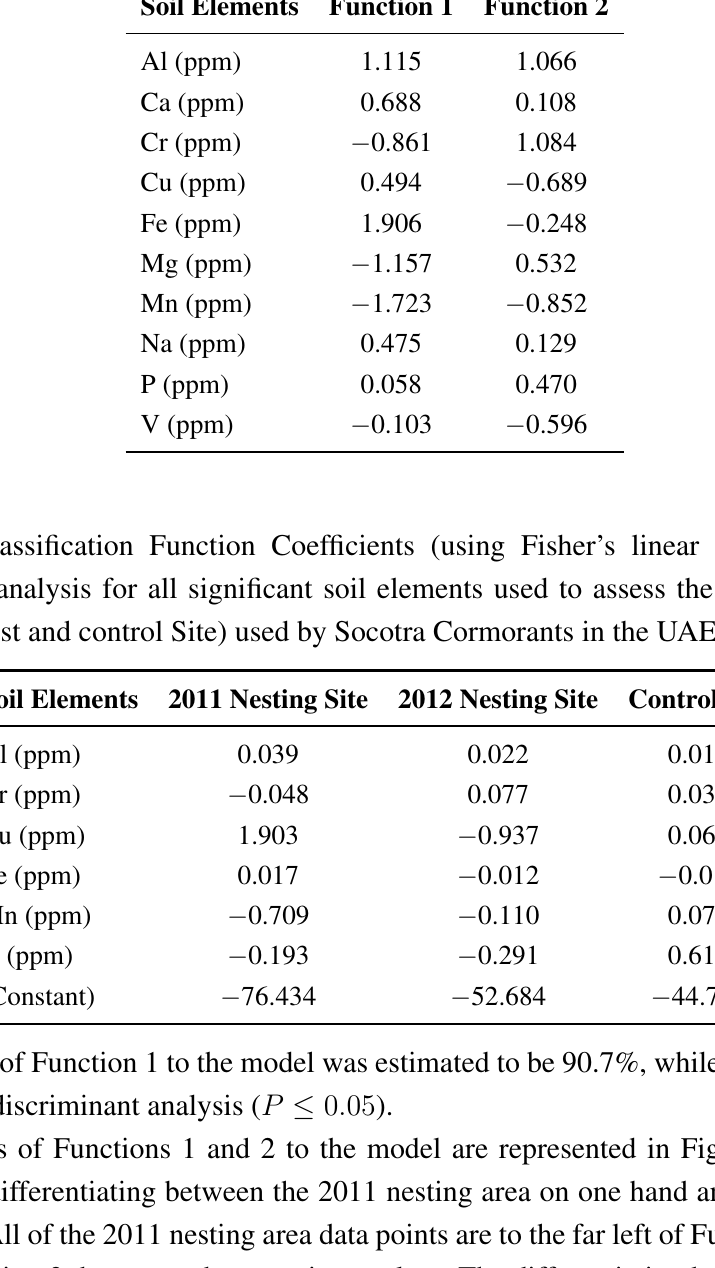
Table 3. Standardized Canonical Discriminant Function Coefficients for all ten soil elements used to assess the three sites (2011 Nest, 2012 Nest and Control Site) used by Socotra Cormorants in the UAE.